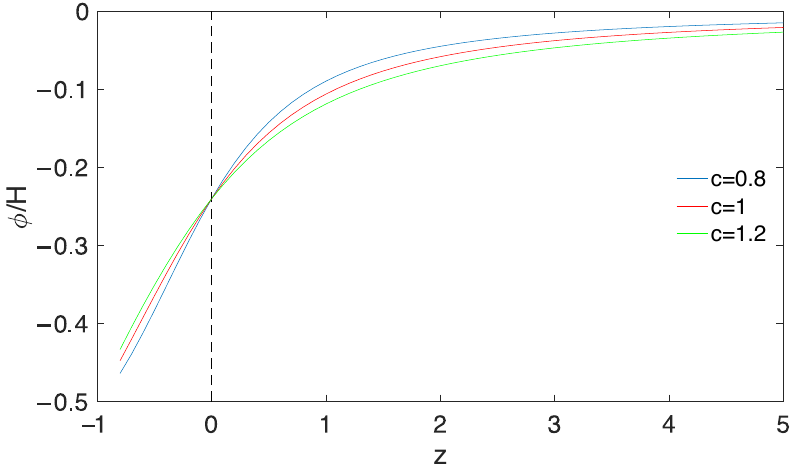
Figure 1. The evolution of the dimensionless ratio φ / H versus redshift z .